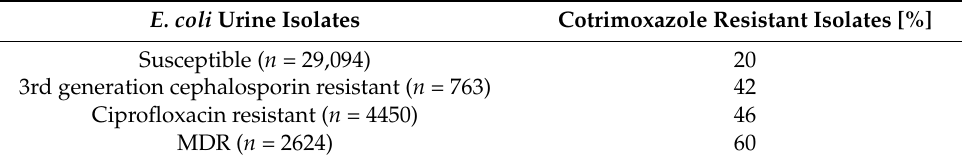
Table 1. Parallel resistance to cotrimoxazole and third generation cephalosporins or ciprofloxacin, respectively, in MDR E. coli urine isolates.